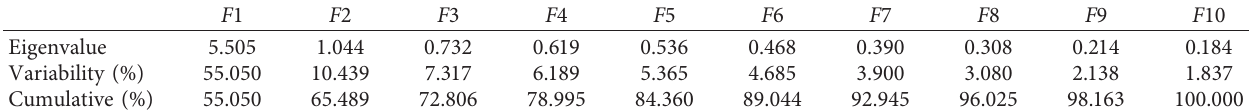
Table 3: Eigenvalues: proportion of explained variability of the score difference.